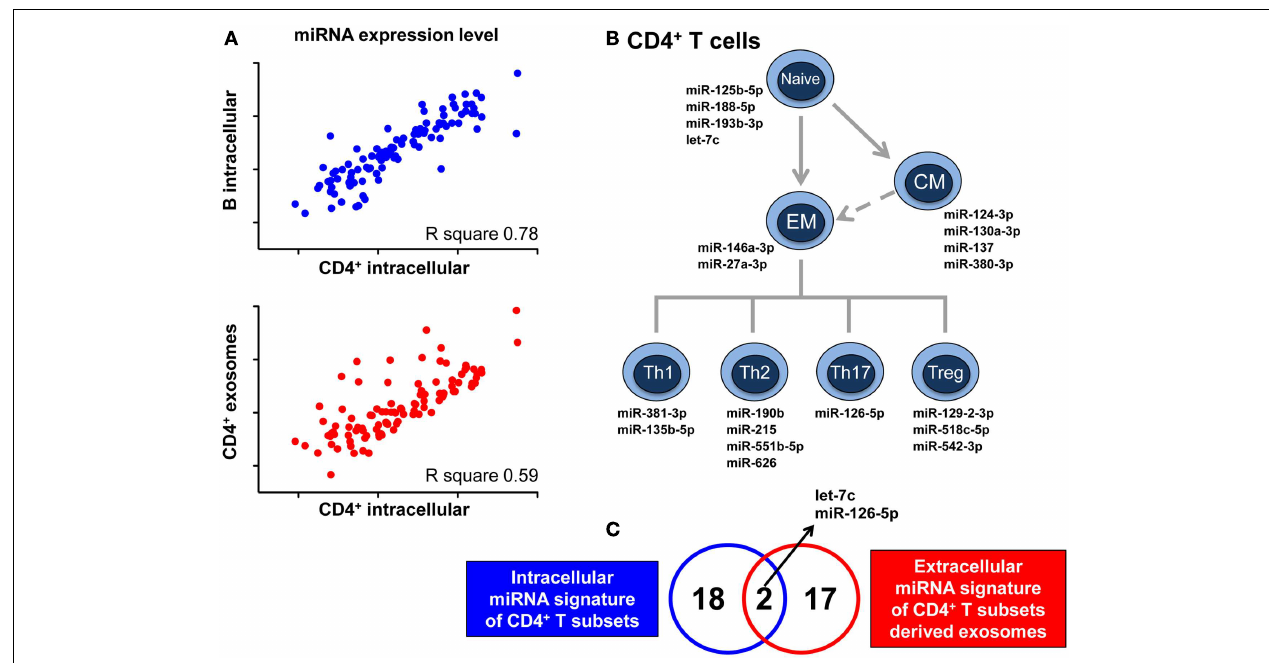
the development and differentiation of these subsets (EM, effector memory; CM, central memory). (C) Venn diagram showing the partial overlap between the 20 miRNAs composing the intracellular signatures of CD4 + T subsets of panel B and the 19 miRNAs at later stage identified for being either exclusive or differentially up-represented in exosomes derived from CD4 + T subsets compared to exosomes derived from B lymphocytes. Data shown are adapted from previous published studies (32,